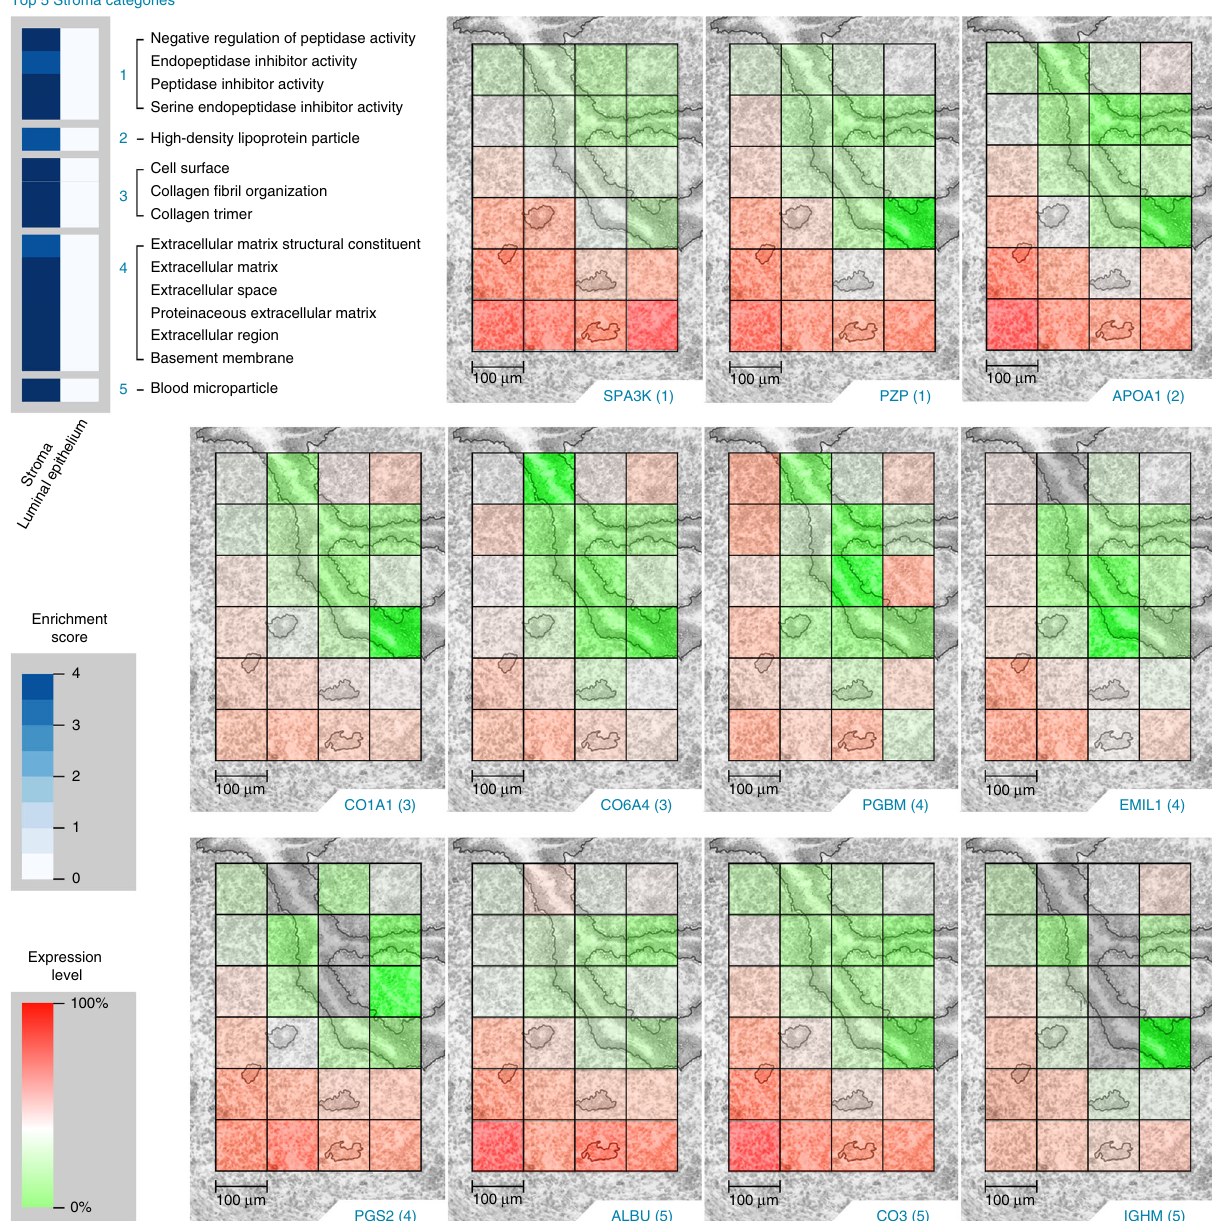
Fig. 5 The top 5 stroma (S) Gene Ontology categories (top, left) enriched in the statistically signi fi cant (Tukey-adjusted ANOVA or a Holm-adjusted g test, p value <0.05) proteins from the dominant cell population study and the corresponding protein images. (1) Serine protease inhibitor A3K (SPA3K), pregnancy zone protein (PZP); (2) apolipoprotein A-I (APOA1); (3) collagen alpha-1(I) chain (CO1A1), collagen alpha-4(VI) chain (CO6A4); (4) basement membrane-speci fi c heparan sulfate proteoglycan core protein (PGBM), EMILIN-1 (EMIL1), Decorin (PGS2); (5) serum albumin (ALBU), complement C3 (CO3), and immunoglobulin heavy constant mu (IGHM). Scale bars, 100 µ m. The authors thank PNNL Graphic Designer Nathan Johnson for preparing the fi